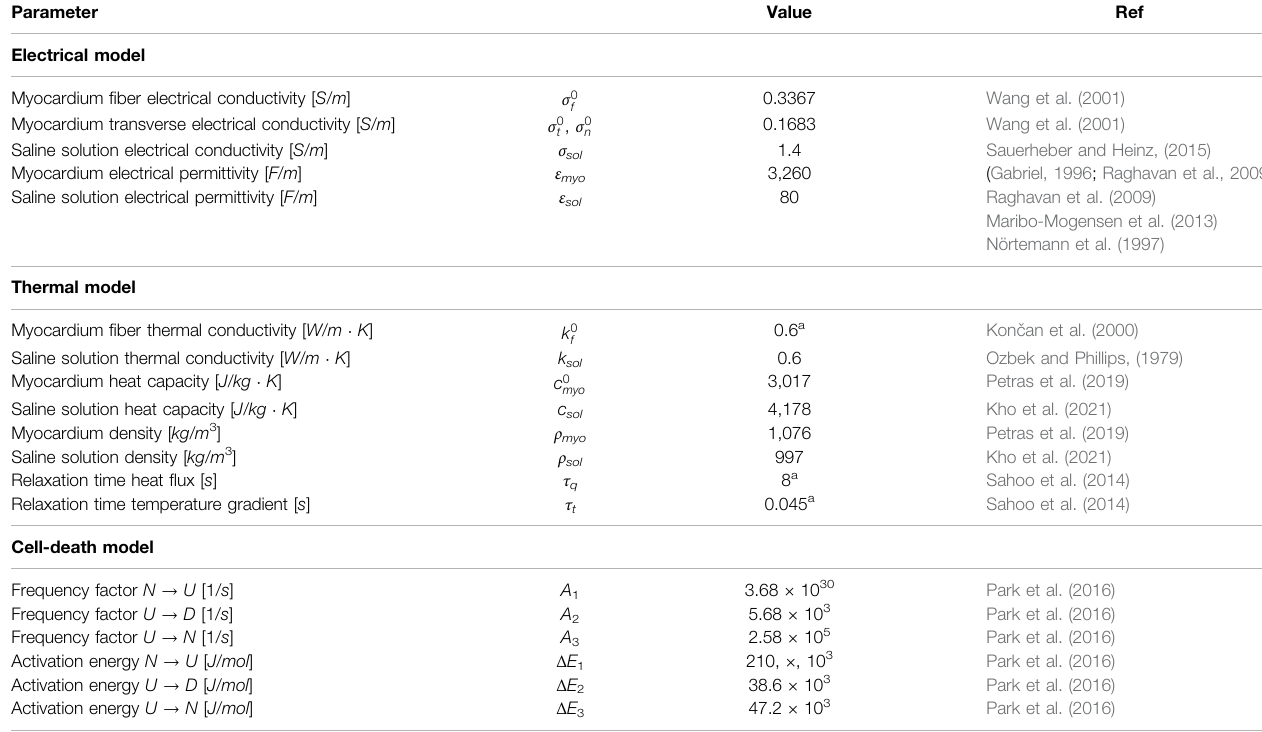
TABLE 2 | Material properties for the 3D model including the myocardium and saline solution domains.